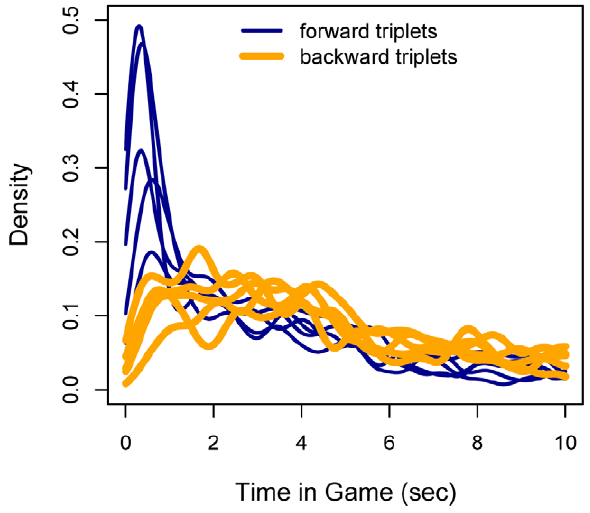
Figure 7. Densities of onset times of forward (blue) and backward (orange)